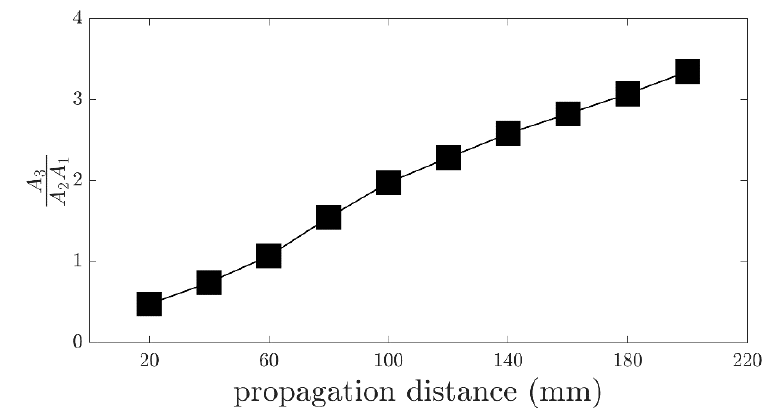
Figure 4. Cumulative behavior of the secondary